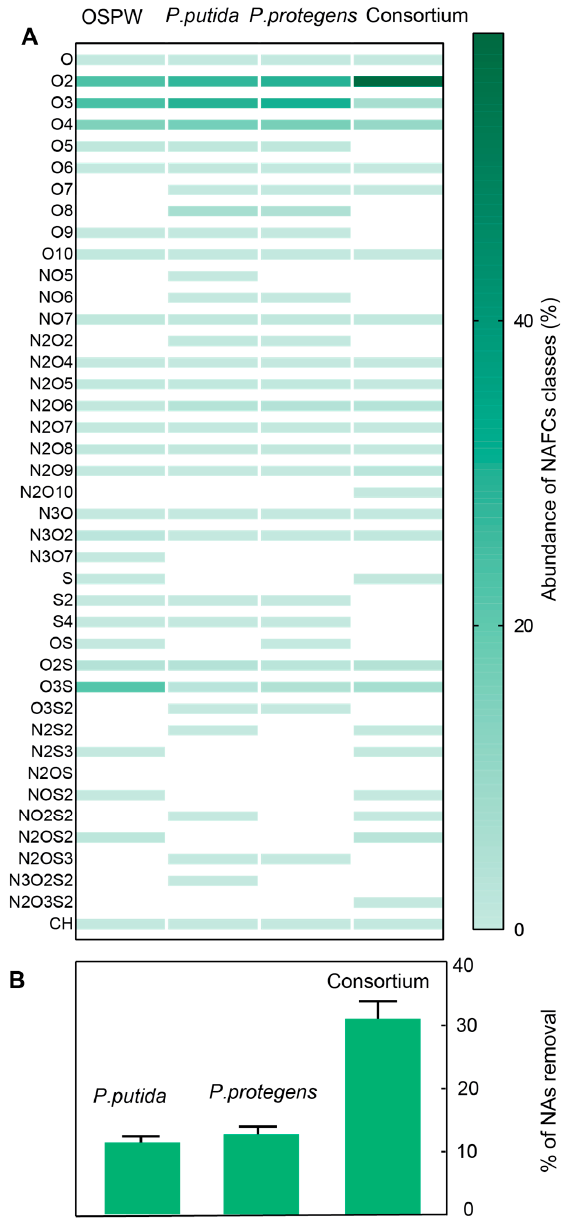
Figure 2. HPLC-Orbitrap results. ( A ) We quantified the relative abundance of the different classes NAFCs in OSPW before and after degradation by pure cultures and a 1:1 co-culture of P. putida and P. protegens. ( B ) We also estimated the total amount of NAs removed by the three cultures. NAs are the major toxicants in OSPW.